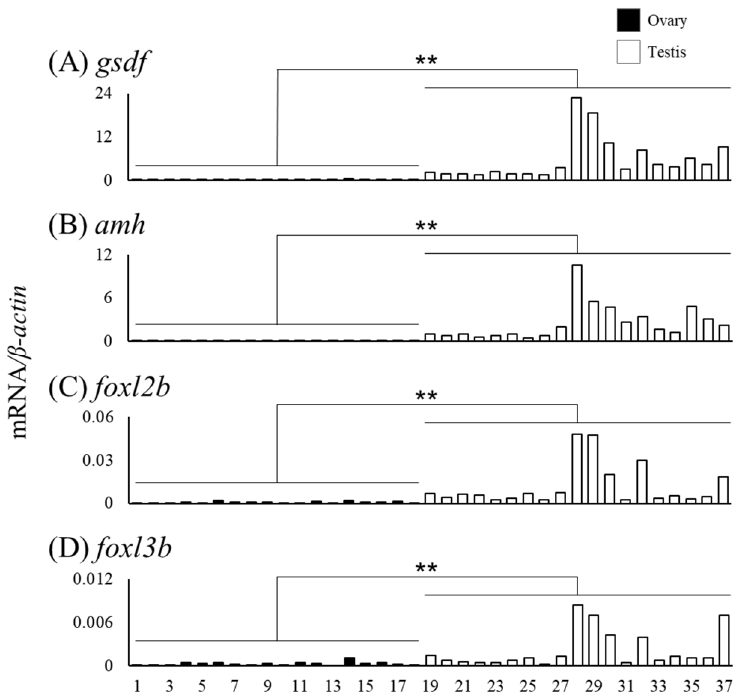
Figure 7. Messenger RNA levels of sex differentiation-related genes ( gsdf , amh , foxl2b and foxl3b ) in the ovary and testis of the wild Japanese eel Anguilla japonica. ( A ) gsdf , ( B ) amh , ( C ) foxl2b and ( D ) foxl3b mRNA levels in the ovary and testis. Each column indicates mRNA levels normalized against β -actin expression. TL in the ovary and testis (Nos. 1–37); for details, see Table 3. ** P < 0.01.